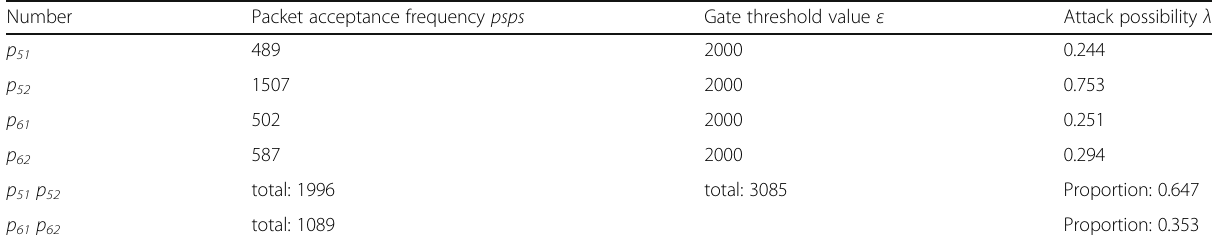
Table 4 The possibility of an attack at this